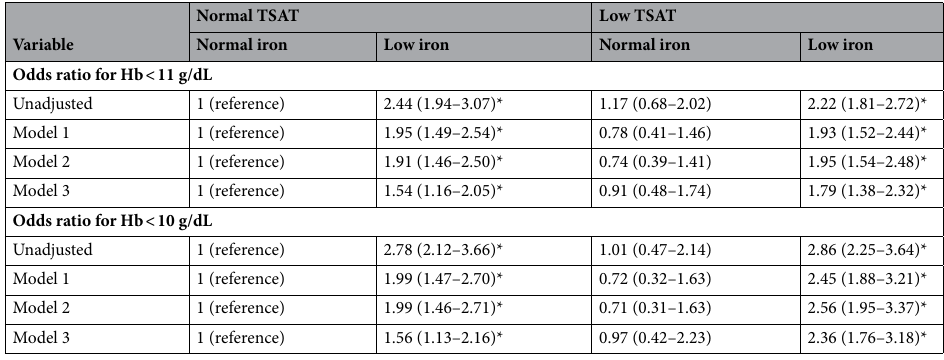
Table 4. Association of TSAT and serum iron with anemia. Model 1 adjusts for Age, Gender, eGFR, UPCR log. Model 2 adjusts for covariates in model 1 plus Diabetes mellitus, Cardiovascular disease, Severe liver disease, Cancer, Mean BP, and Body mass index. Model 3 adjusts for covariates in model 2 plus Albumin, CRP log, Ferritin Log, and Phosphorus. *Meant statistically significant compared with reference